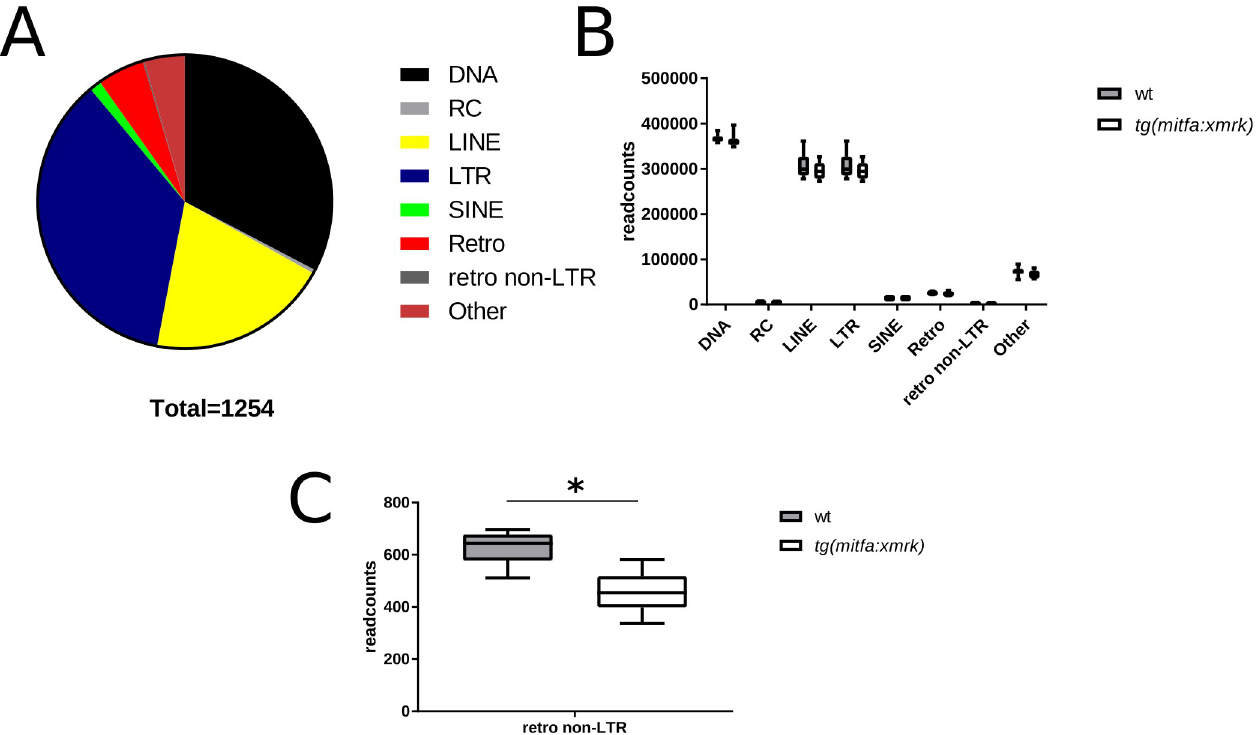
Fig 1. Families of expressed TEs found in RNA-seq data of wildtype and tg(mitfa:xmrk) larvae. (A) In total 1254 TE families were found to be expressed. A TE was considered as expressed, if at least one read was mapped to the consensus sequence. The diagram represents the percentage of the indicated TE categories in the total amount. (B) Sum of all DESeq normalized read counts of the indicated category in wt and transgenic fish for analyzing if one category is overexpressed in one of the samples. No significant differences in expression except for the retro non-LTR (C) could be observed. These elements have significantly more ( � p < 0.05) read counts in wildtype